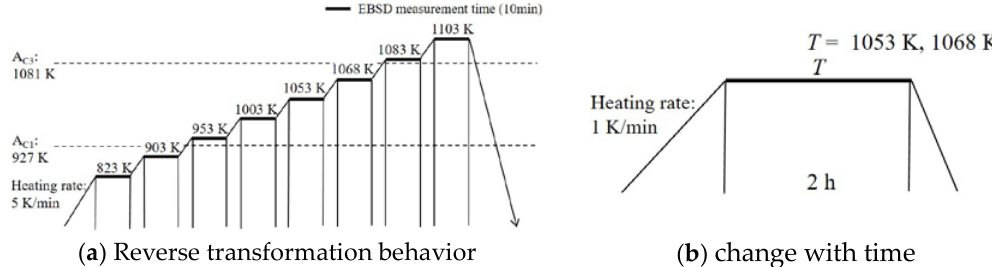
Figure 5. In situ EBSD test conditions of the evaluation of reverse transformation behavior ( a ) and change over time ( b ).